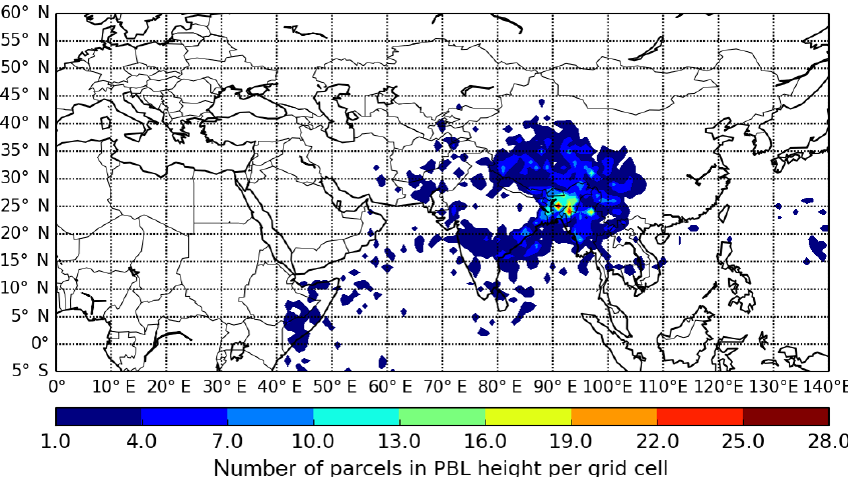
Figure 11. Last boundary layer contact of parcels from trajectories, which start along the flight track at locations with CH 4 mixing ratios above the threshold, before they were transported to the track of flight 19 (10 days prior to flight).